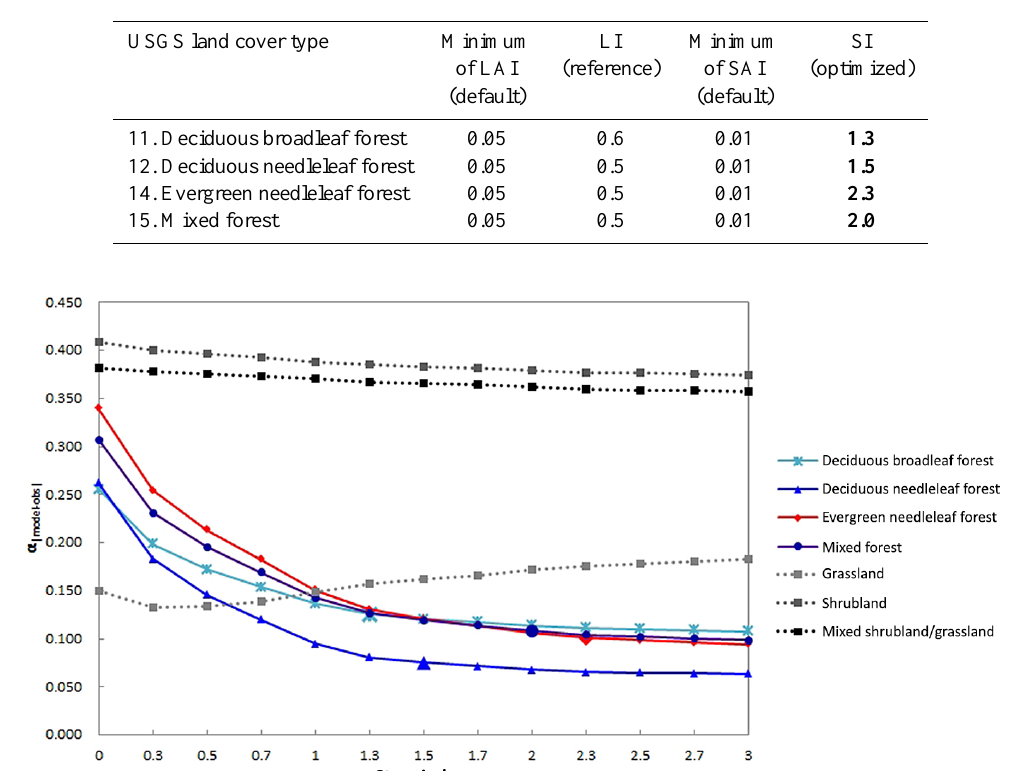
Figure 6. Sensitivity of the winter-averaged albedo to SI over four forest types and three short vegetation types in the Noah-MP for 2001– 2010. The optimized value for each forest type is indicated with a larger